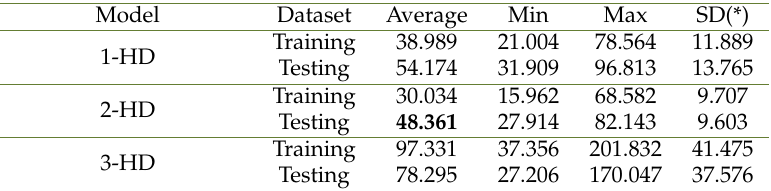
Table 7. Summary of the 1000 simulations using MAE criteria Model